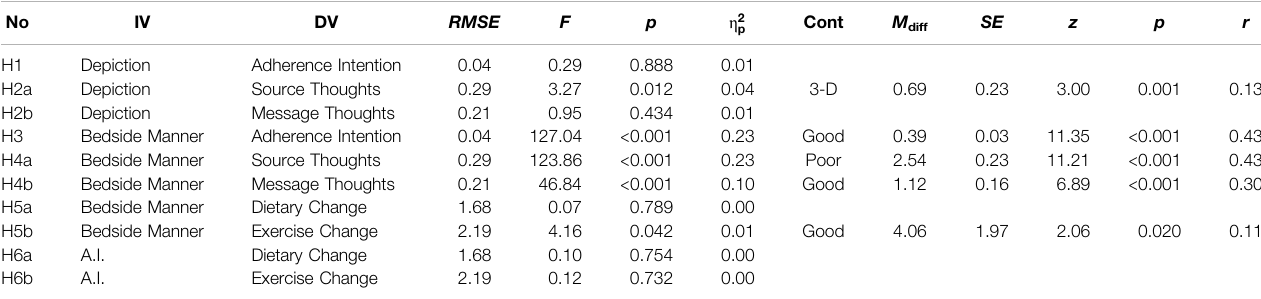
TABLE 3| Mixed-effectsmodel ofbedsidemannerand depiction on Adherence Intention, number ofsource- and message-relatedthoughts,DietaryChange, and Exercise Change with planned contrasts. No